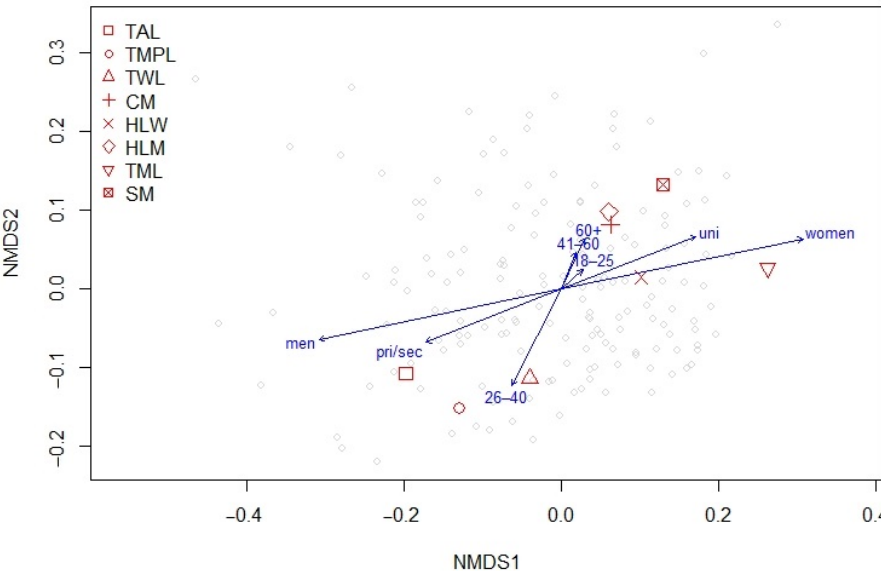
Figure 11. Multidimensional scaling of respondent perceptions on biocultural landscapes that need